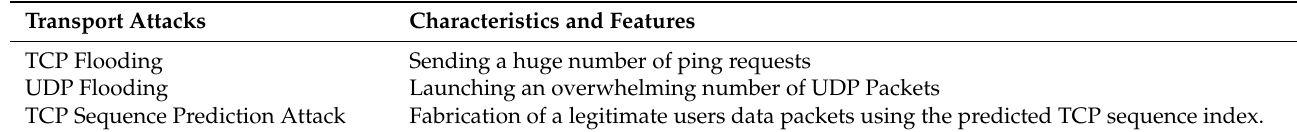
Figure 9. ( A ) Wireless Sensor Network with three locations. ( B ) Wormhole attack by attacker. In wireless sensor networks, the nodes send a special message that is known as a “hello” message. These messages are used in order to discover the nodes in a network and also to insert a new node into a network. While attacking this kind of network, the attacker tries to produce congestion in the network by overloading the network, which allows the attacker to consume all the energy of the nodes which are there in the network [82,83]. Figure 10 (below) shows a diagram of a Hello Flood attack. Through this procedure, the unauthorized uses a powerful antenna to generate hello packets into the network, and all the neighbors of that node in the network try to answer it. Due to the reply, it will allow the energy of the nodes to be consumed [85]. Figure 10 (below) shows the image of the hello flood attack.